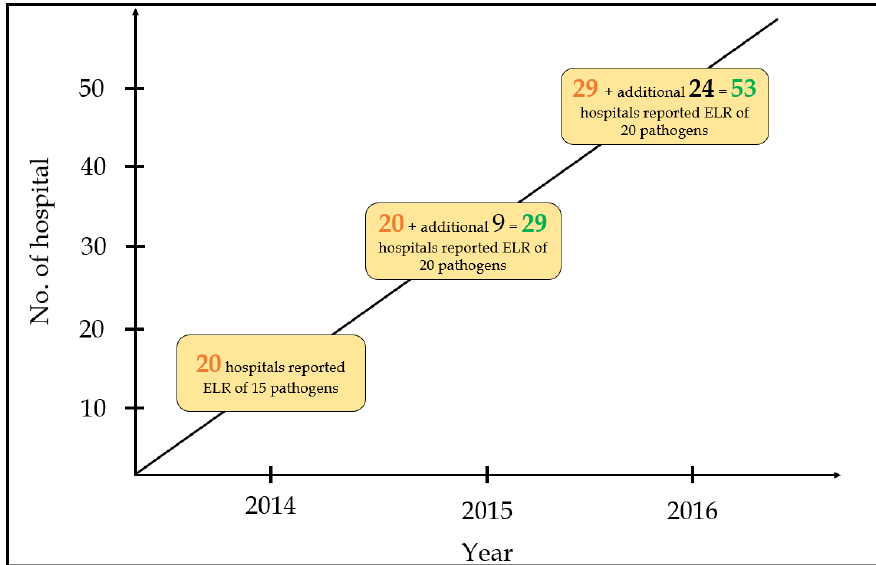
Figure 4. Number of hospitals and reported pathogens during the three-year study period.